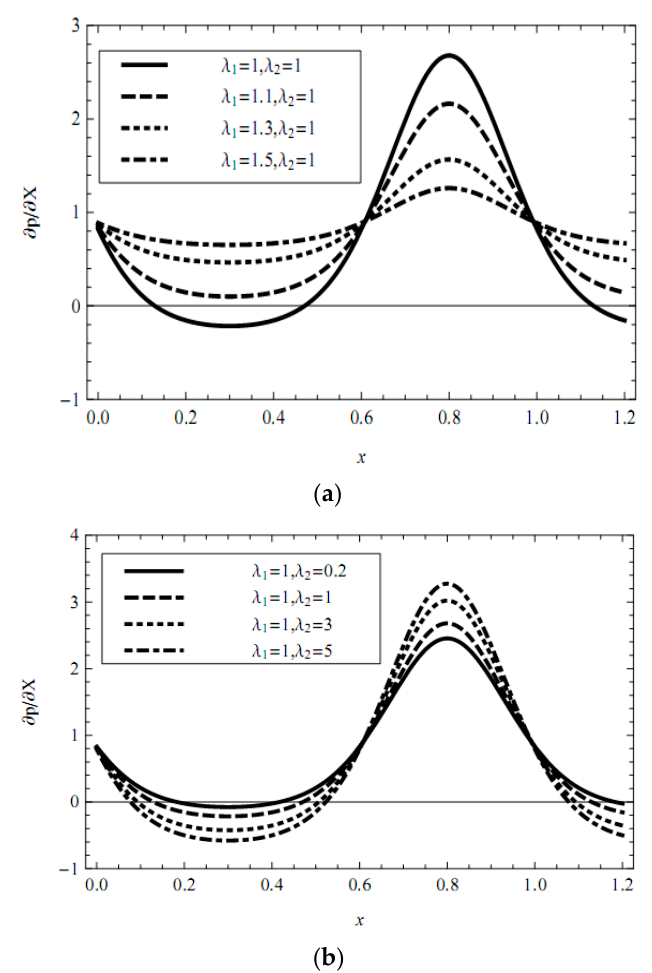
Figure 4. Profiles of the pressure gradient for various values of fractional operator parameter ( a ) α and ( b ) β with fixed λ 1 = 1, λ 2 = 1, m = 1, (cid:2038) = 0.3, (cid:1847) HS = 1, (cid:1843)(cid:3364) = 0.1, t = 0.8.